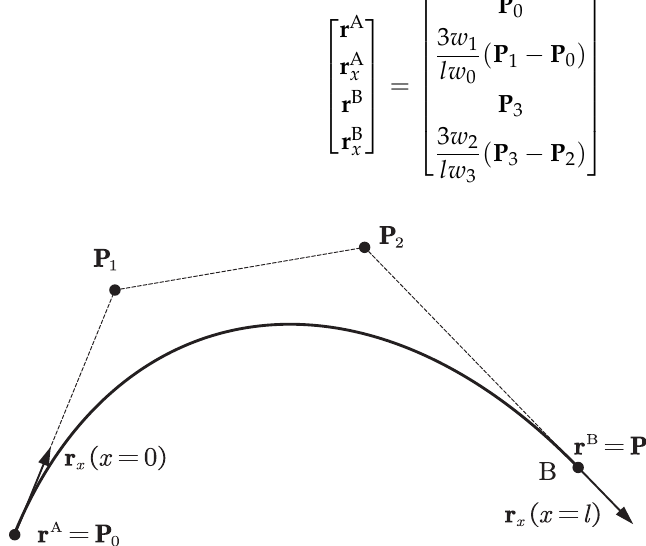
Figure 1. Rational absolute nodal coordinate formulation (RANCF) beam element